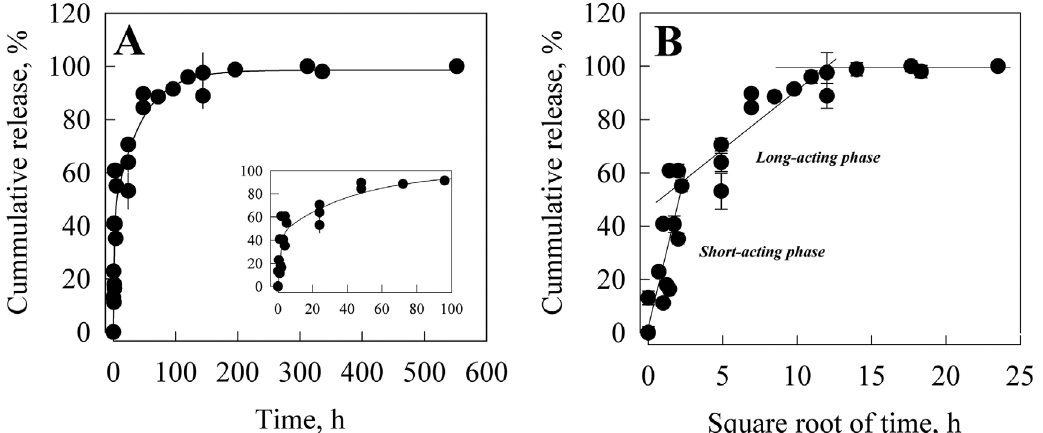
FIGURE 3 - Kinetics of human insulin release from PCL microparticles. A) Cumulative release in a linear time scale. Inset: detail view of kinetics at initial range. Solid lines correspond to best fitting using Equation 1. Results are depicted in Table I and II. B) Higuchi plot. Solid lines are solely to depict human insulin releasing phases. Data represents measurements in triplicate from kinetics performed with three microparticles